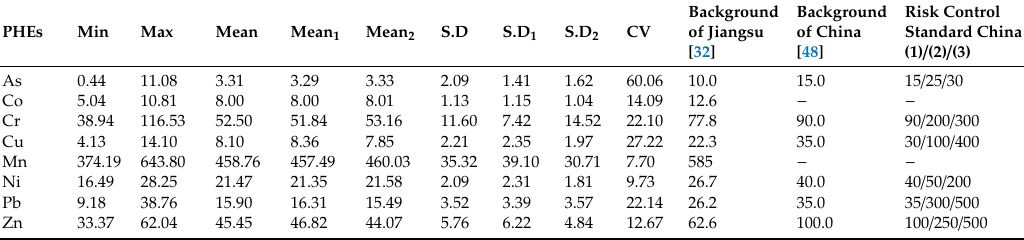
Table 3. Statistical description of PHEs contents in the study area (mg · kg − 1